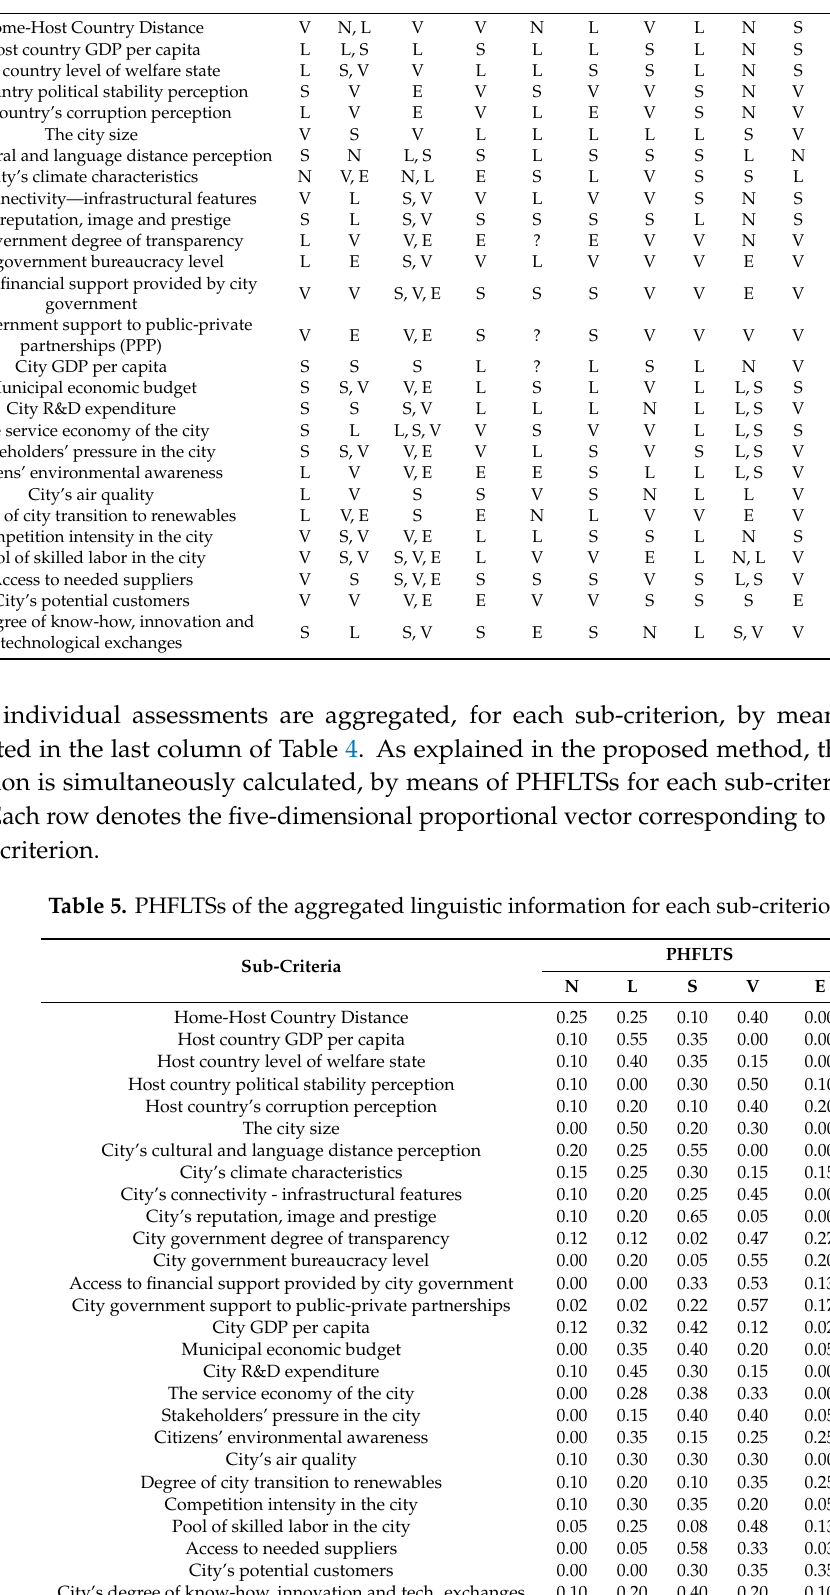
Table 4. Linguistic expressions given by the ten experts in relation to the importance of each sub-criteria. Sub-Criteria Home-Host Country Distance